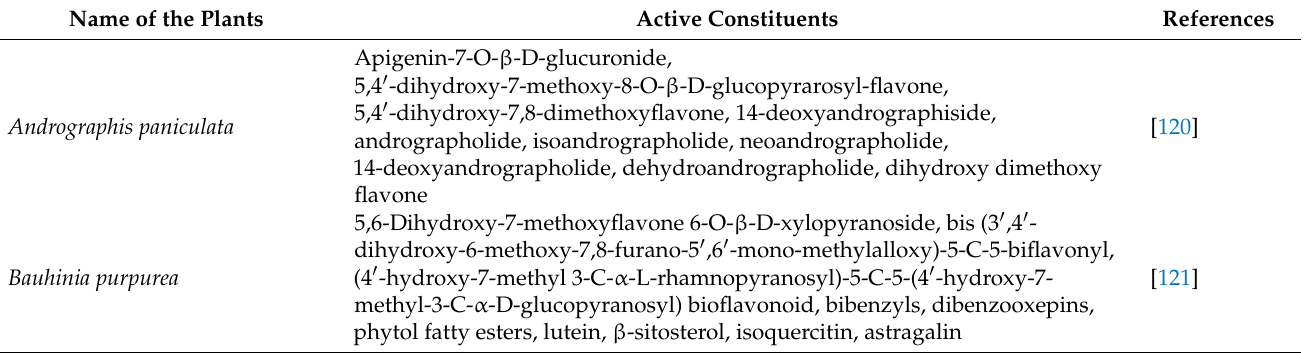
Table 2. Chromatographic analyses of the active constituents of the reviewed hepatoprotective